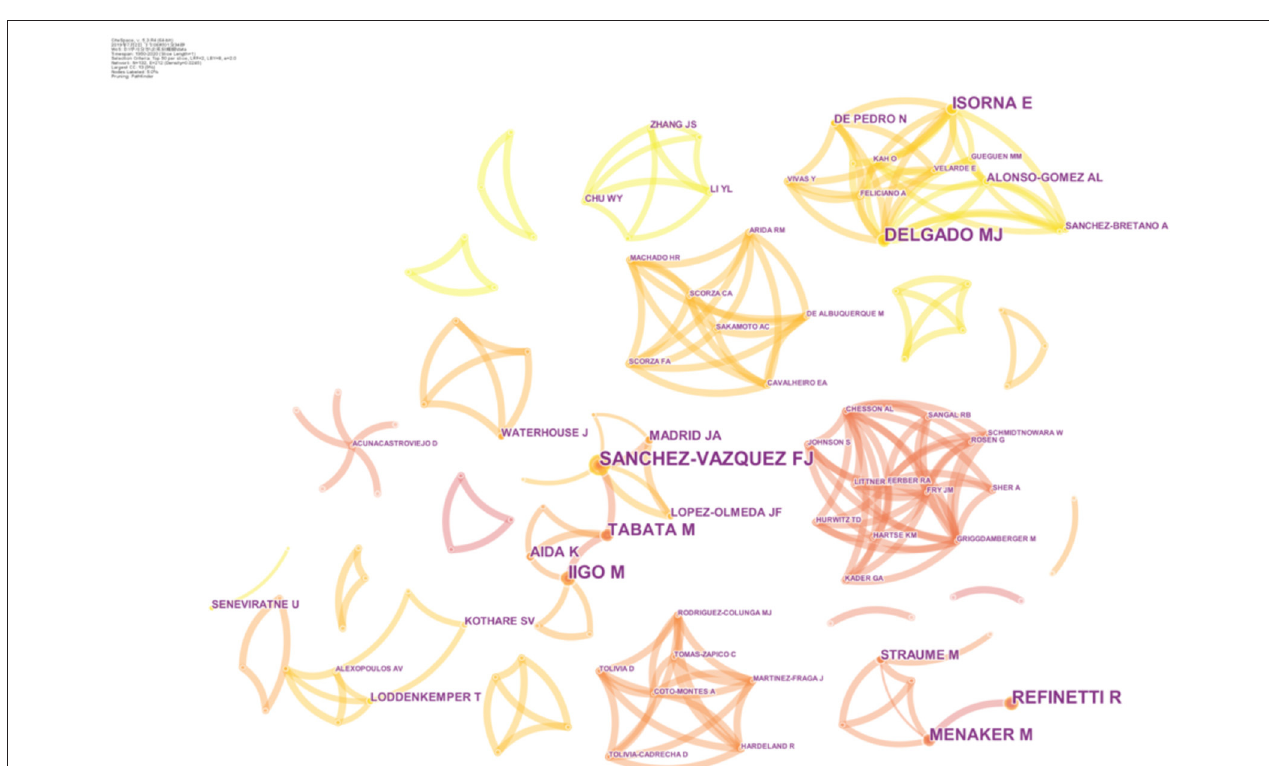
FIGURE 3 | The network of